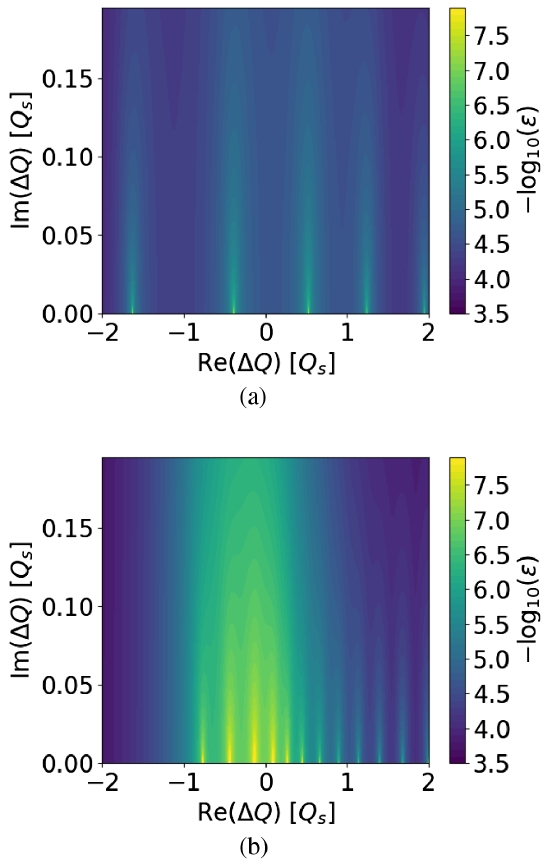
FIG. 5. Pseudospectrum of the one turn matrix with weak (above) and strong (below) space charge forces, both being above the decoupling of the original TMCI by space charge.